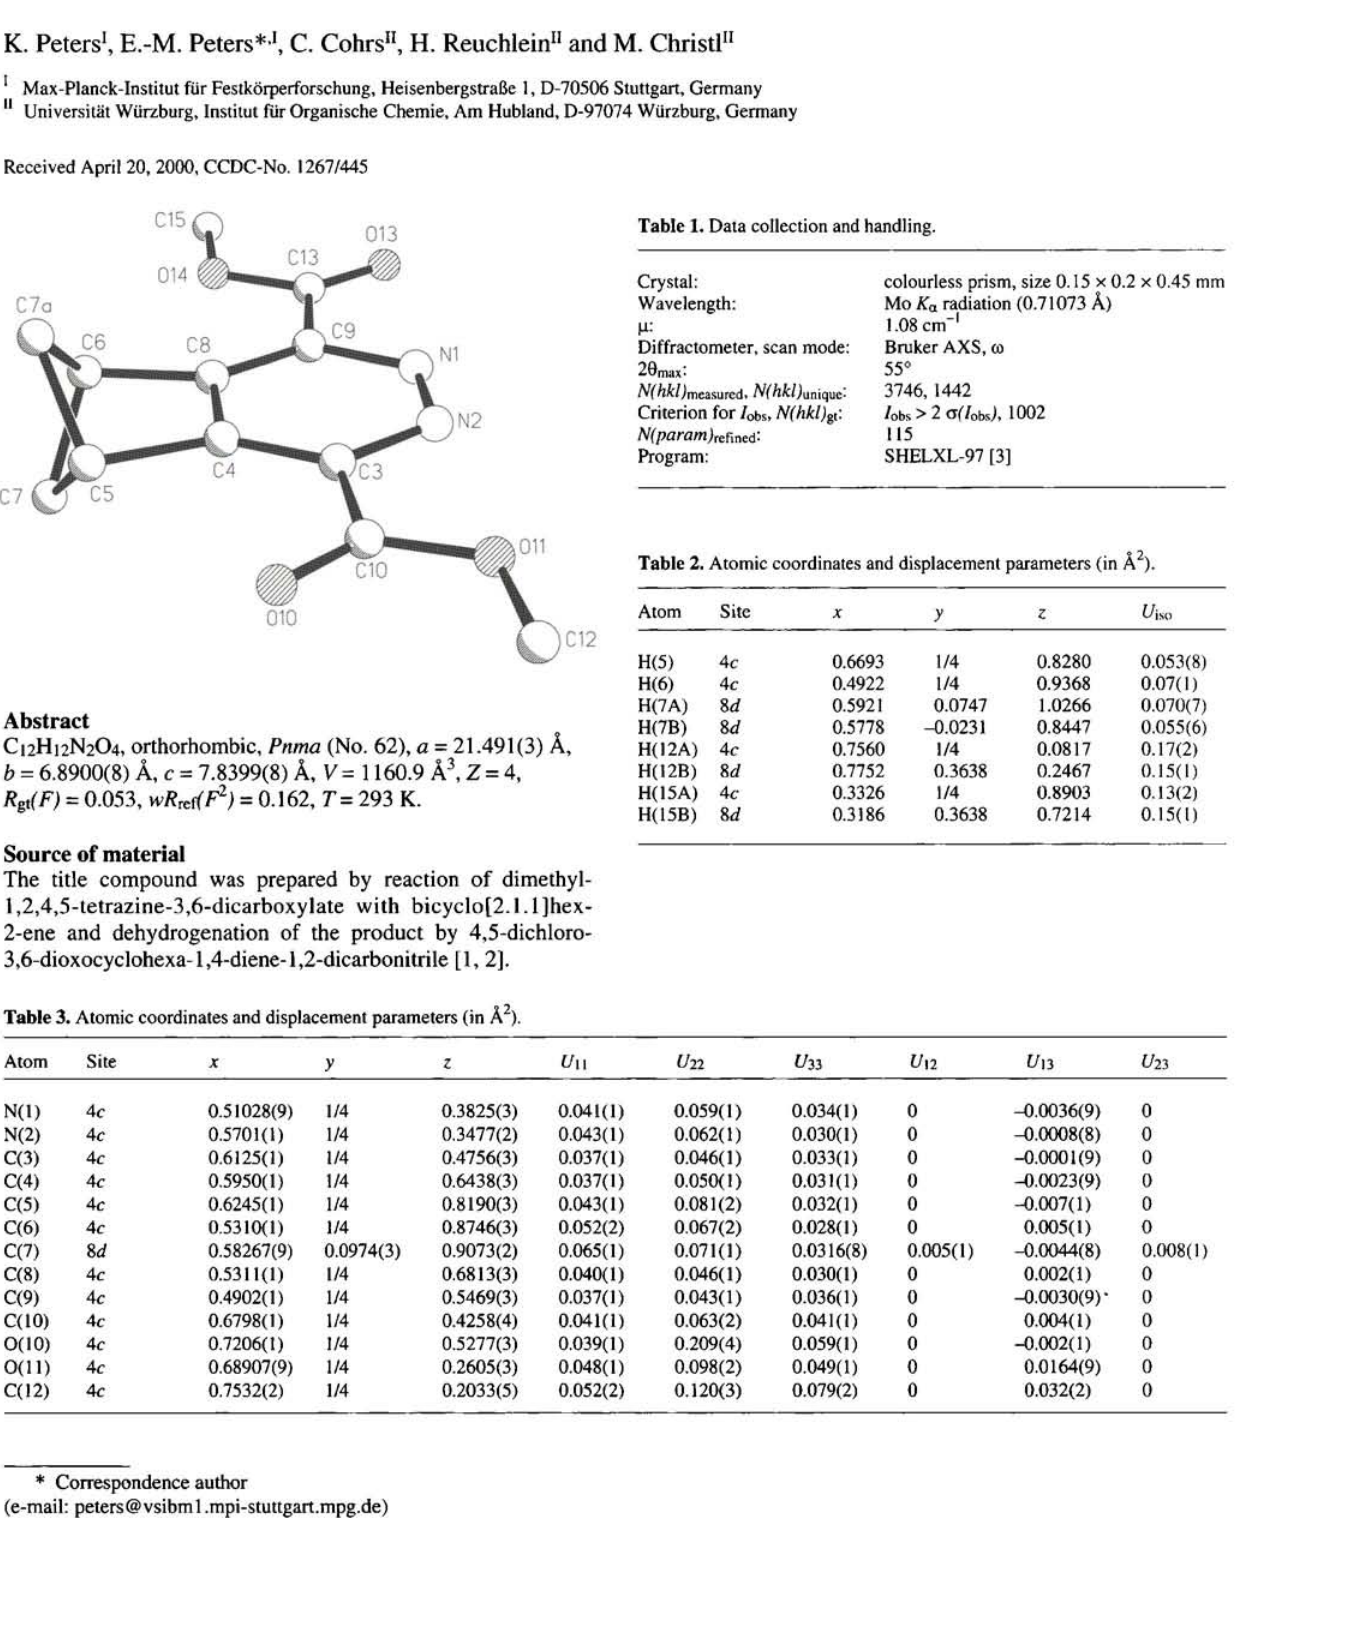
Table 1. Data collection and handling.